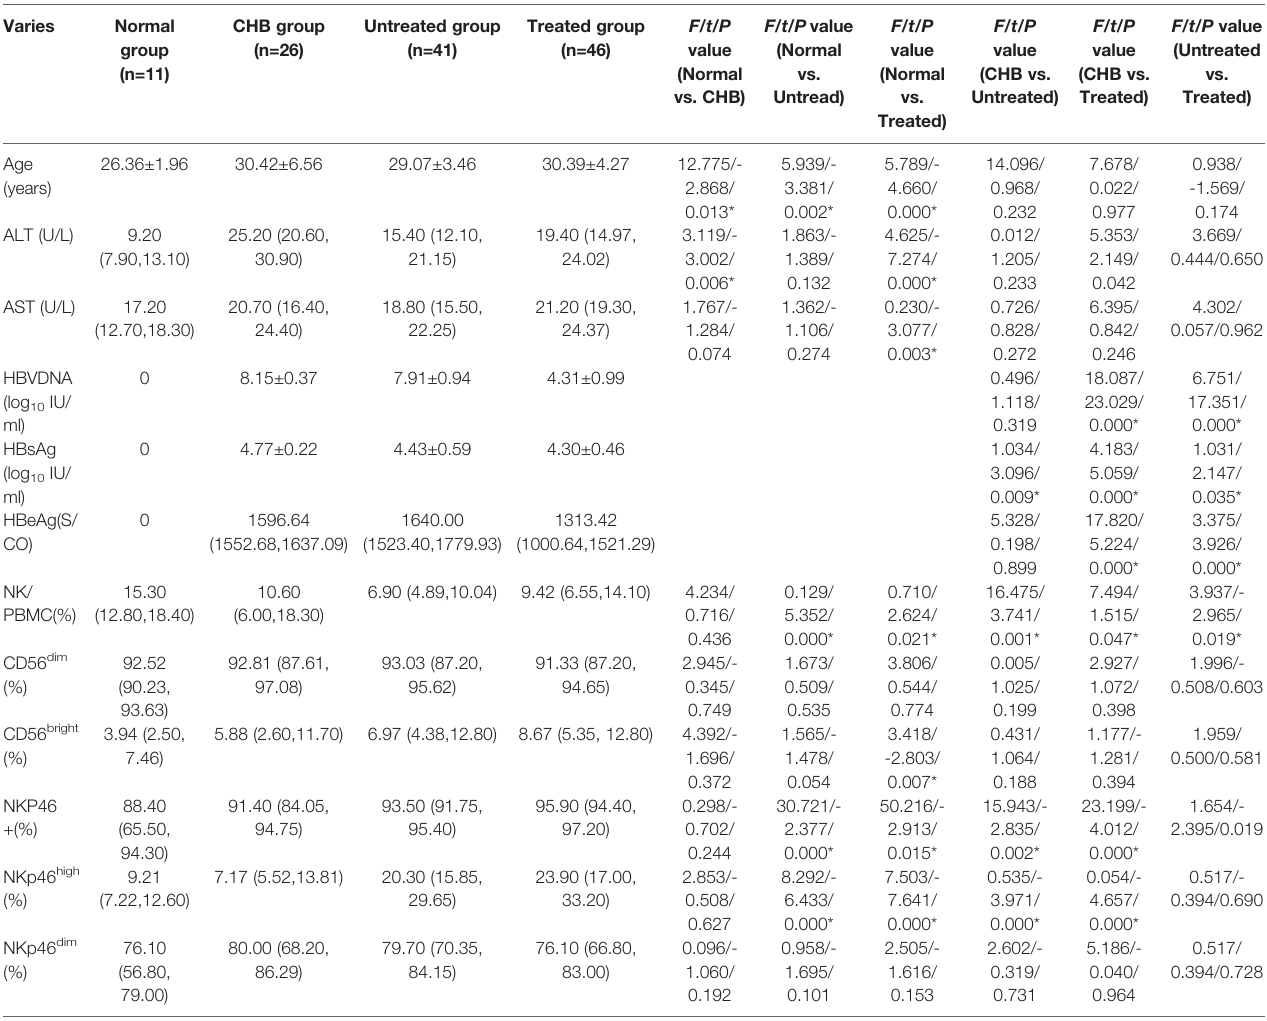
TABLE 1 | Baseline characteristics of the study